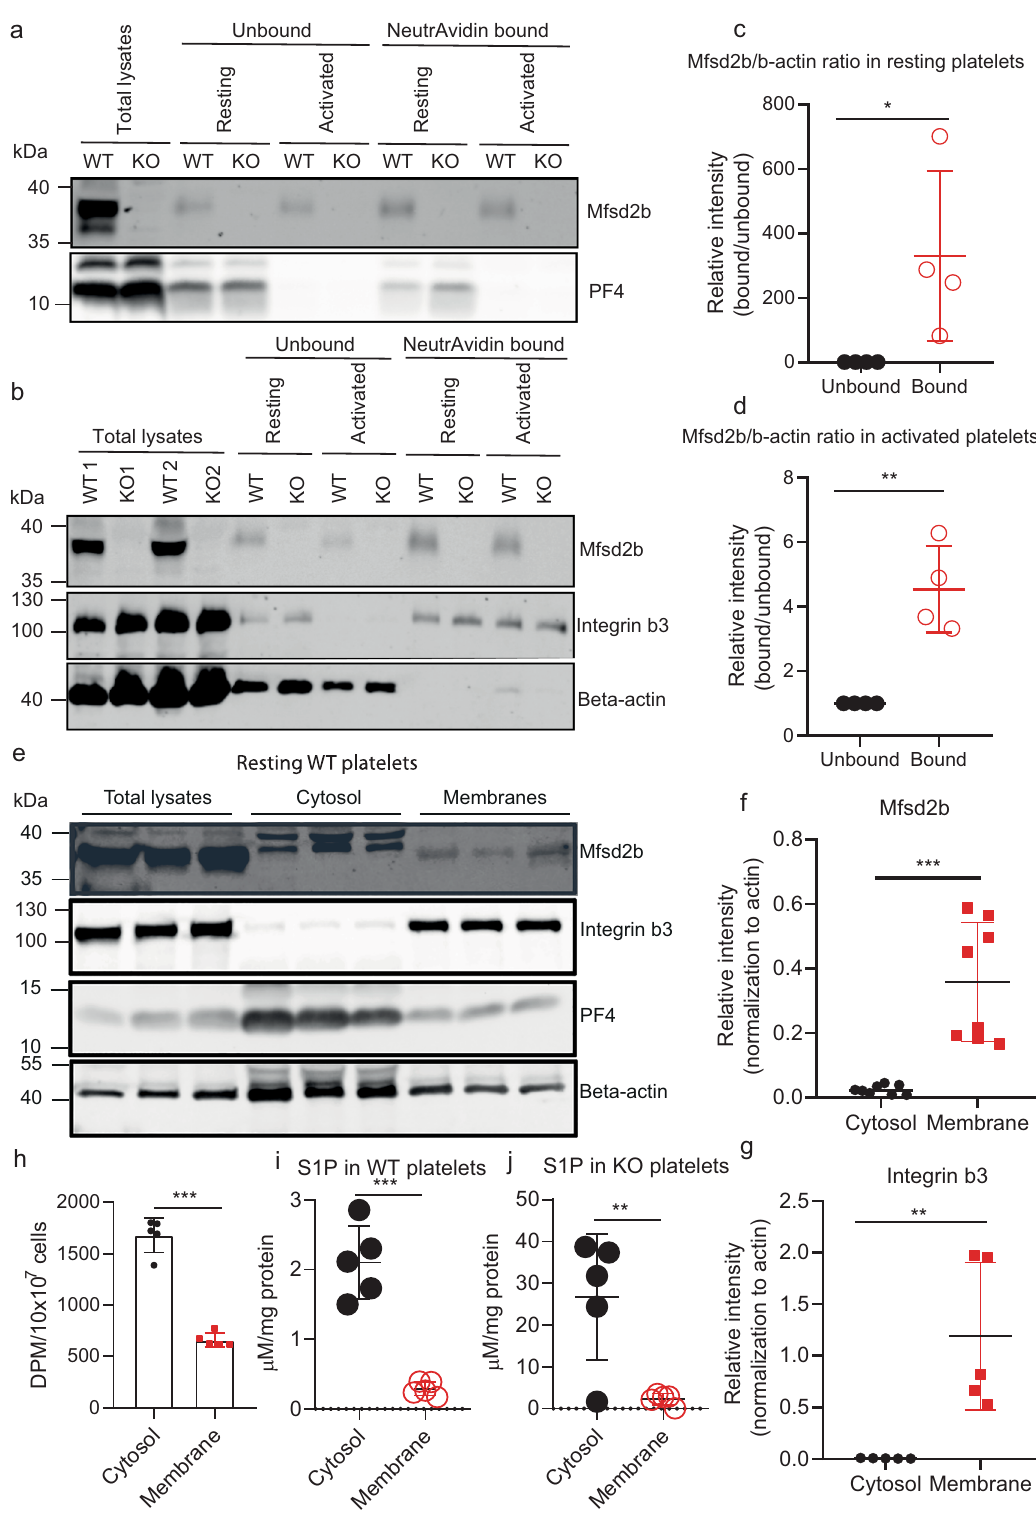
WT and Mfsd2bf/fPF4 knockout platelets compared with that from membrane fractions (Fig. 2i, j). These results show that in resting platelets S1P is predominantly localized in the cytoplasm. Together, our results show that Mfsd2b is mainly expressed in the plasma membrane, whereas most of the S1P content is found in the cytoplasm in resting platelets. These results likely explain the ability of storing S1P in resting